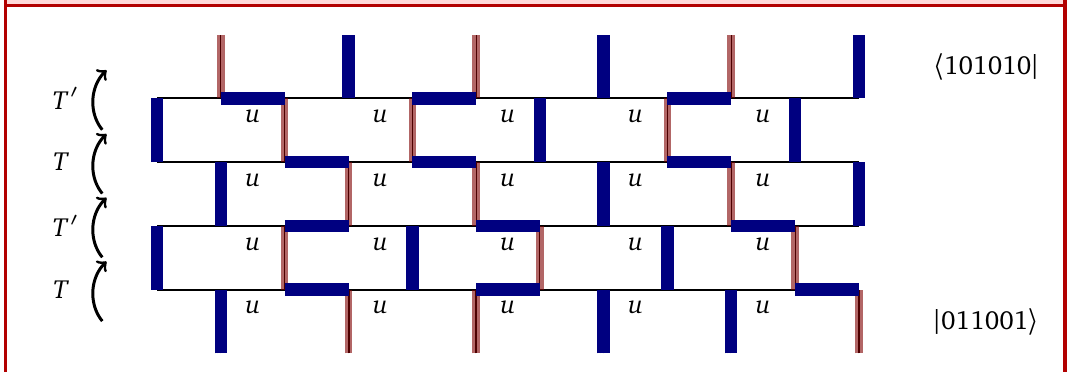
Figure 10: Transfer matrix for dimers on honeycomb